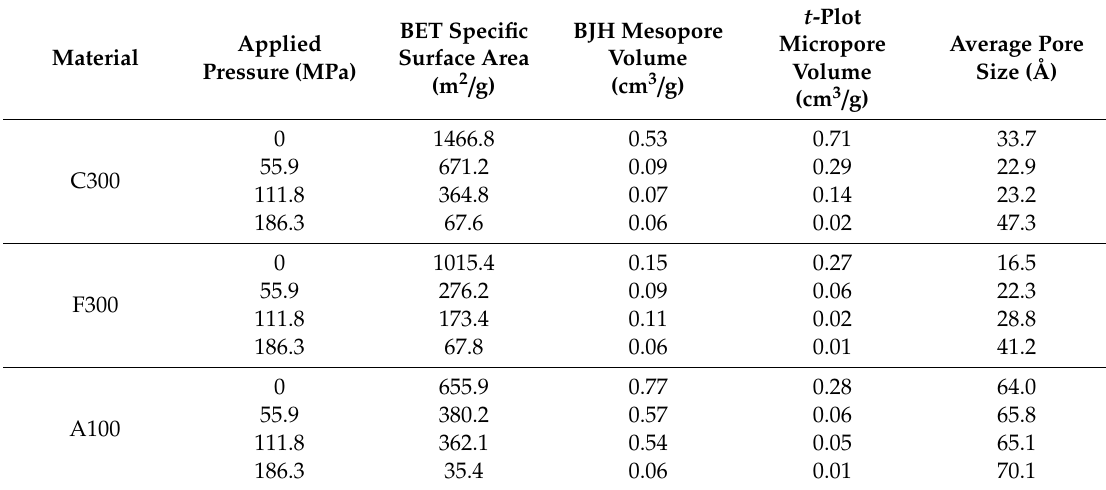
Table 1. Variations of Brunauer–Emmett–Teller (BET) surface area, Barrett–Joyner–Halenda (BJH) total mesopore volume, t -plot total micropore volume and average pore size with applied pressure.